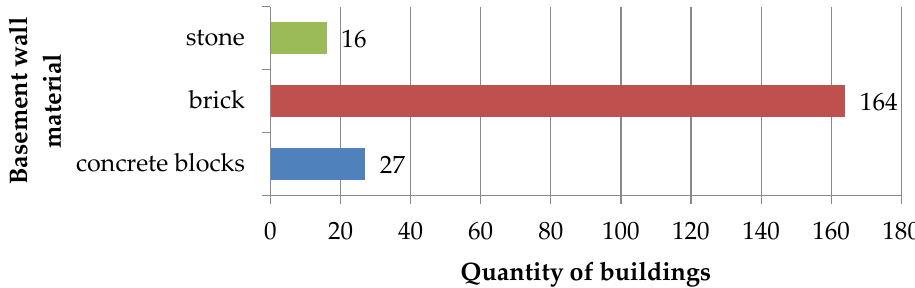
Figure 14. Distribution of data for the variable relating to the type of foundation.